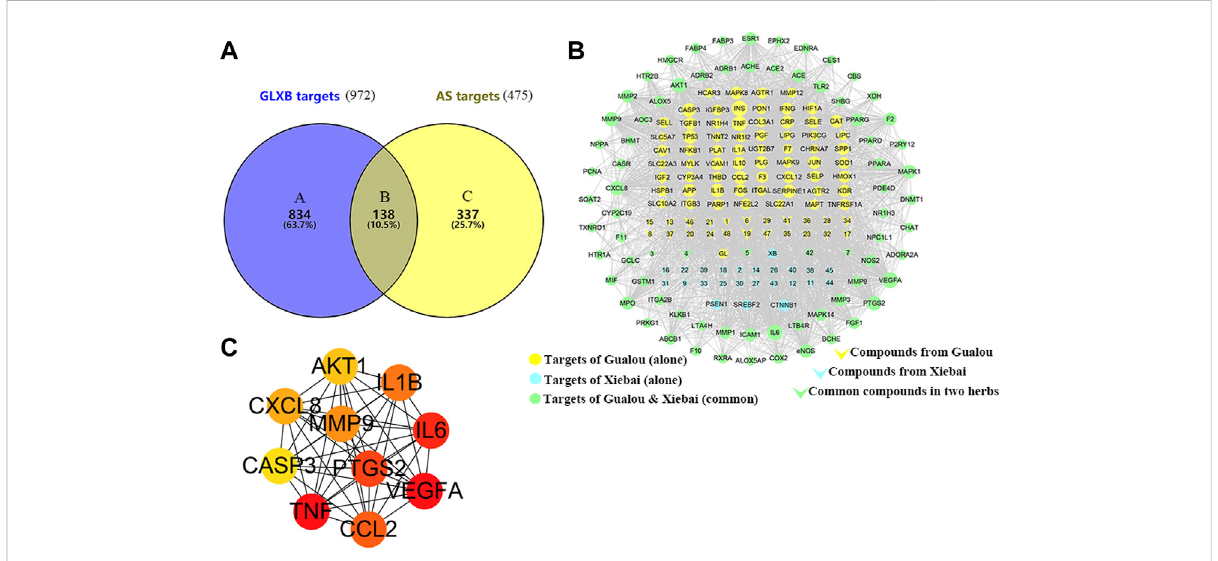
FIGURE 4 Target mapsofGLXBon AS. (A) TheVenndiagram ofthetarget ofGLXBagainst AS. (B) Compound – target network ofGLXB.Targets ofGualou: labeledasyellowcirclenodes;targetsofXiebai:labeledasbluecirclenodes;targetsofGualouandXiebai:labeledasgreencirclenodes;compounds from Gualou: labeled as yellow triangle nodes; compounds from Xiebai: labeled as blue triangle nodes; common compounds in two herbs: labeled as green triangle nodes. (C) Ten key targets of GLXB on